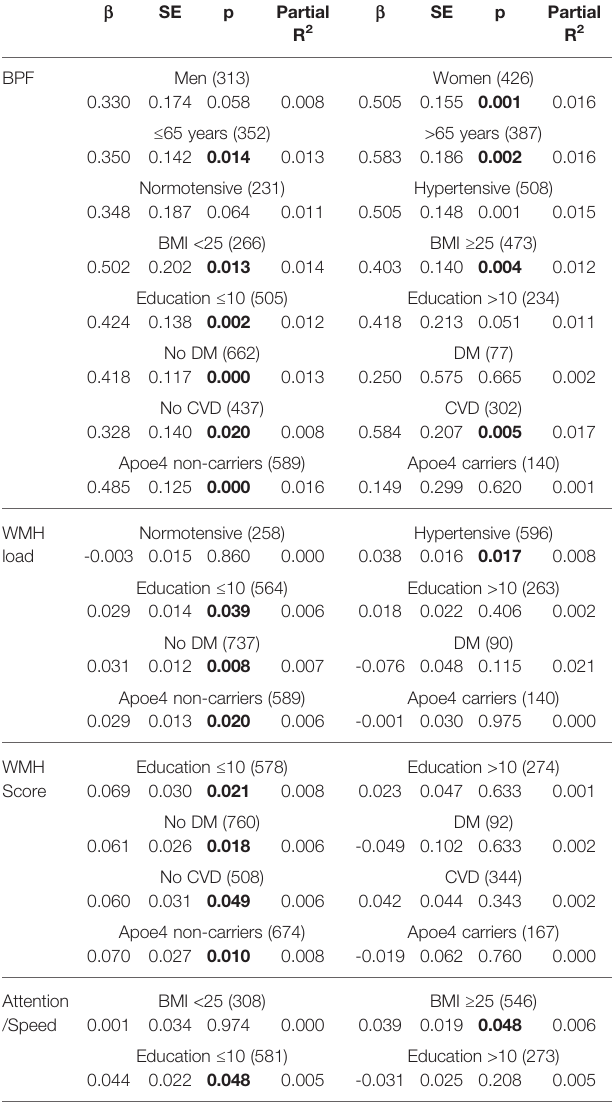
TABLE 2 | Linear regression analysis of the association of leukocyte telomere length (LTL) with magnetic resonance imaging (MRI) correlates and cognitive functions.